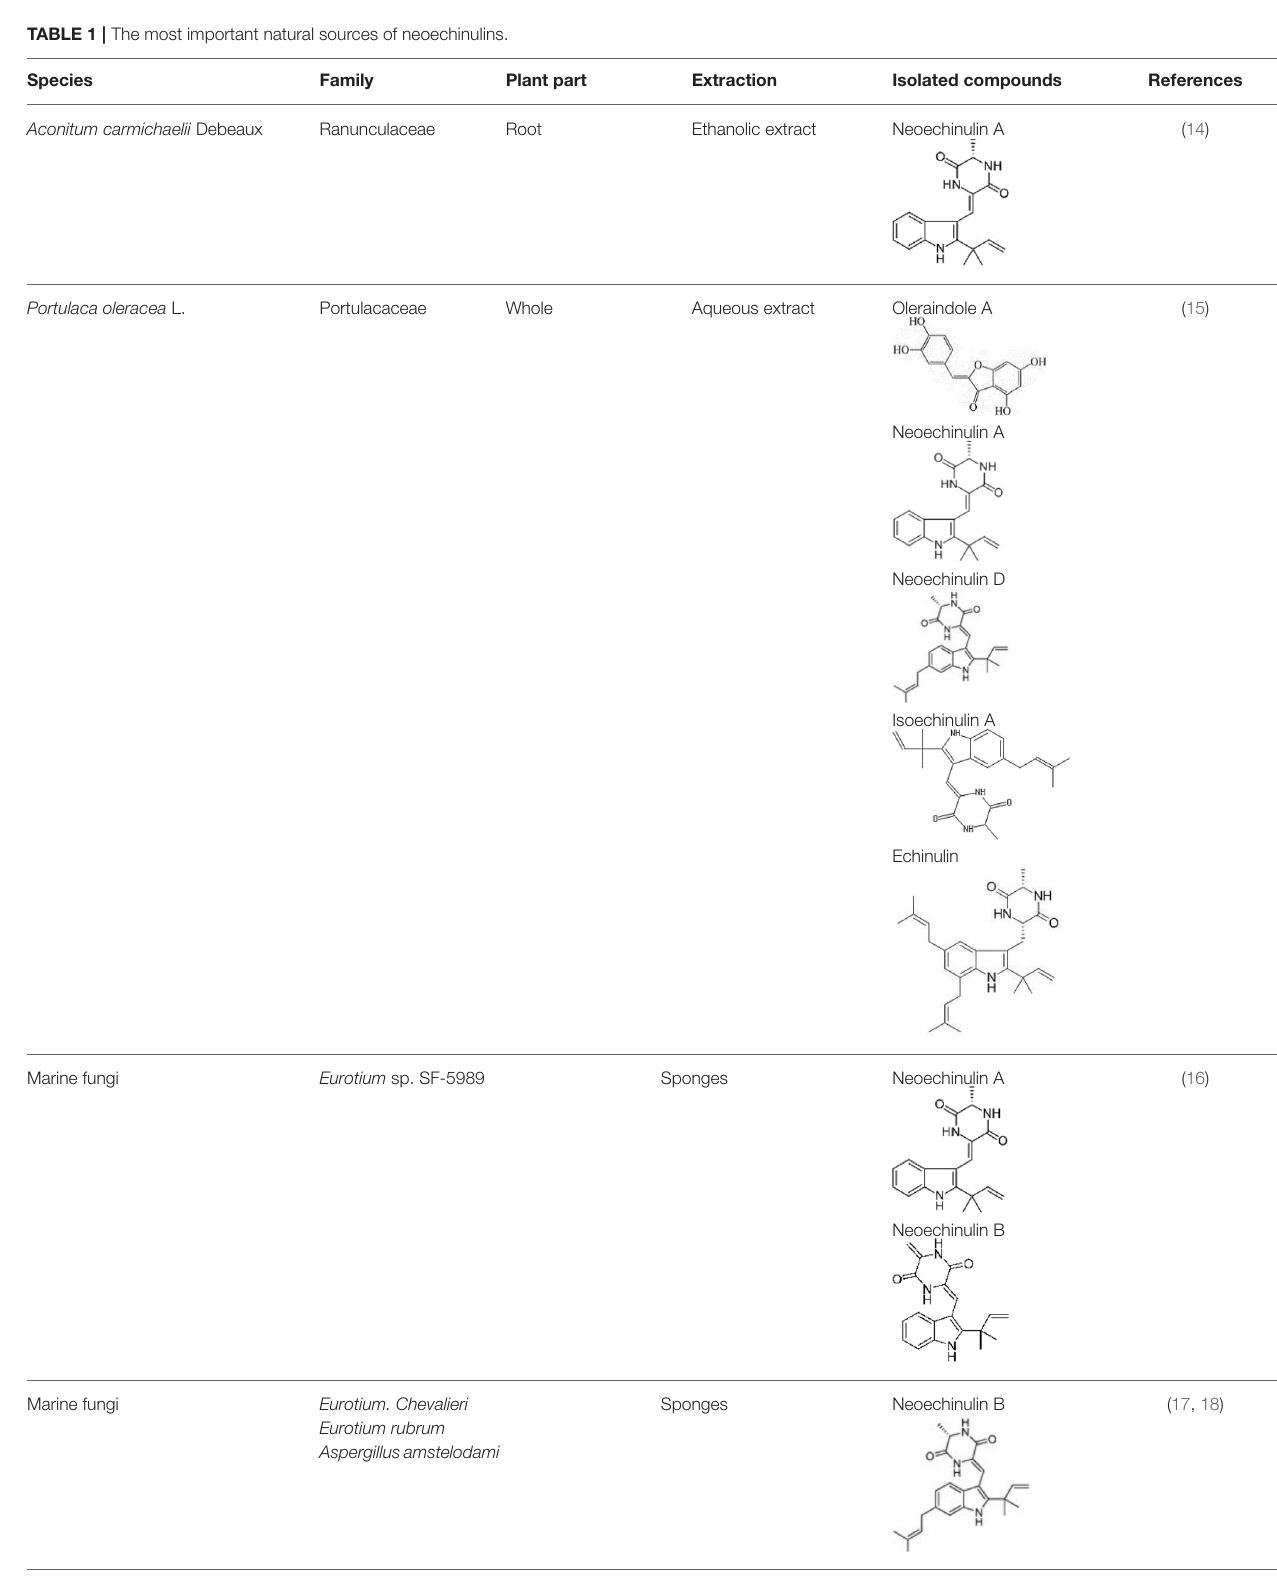
TABLE 1 | The most important natural sources of